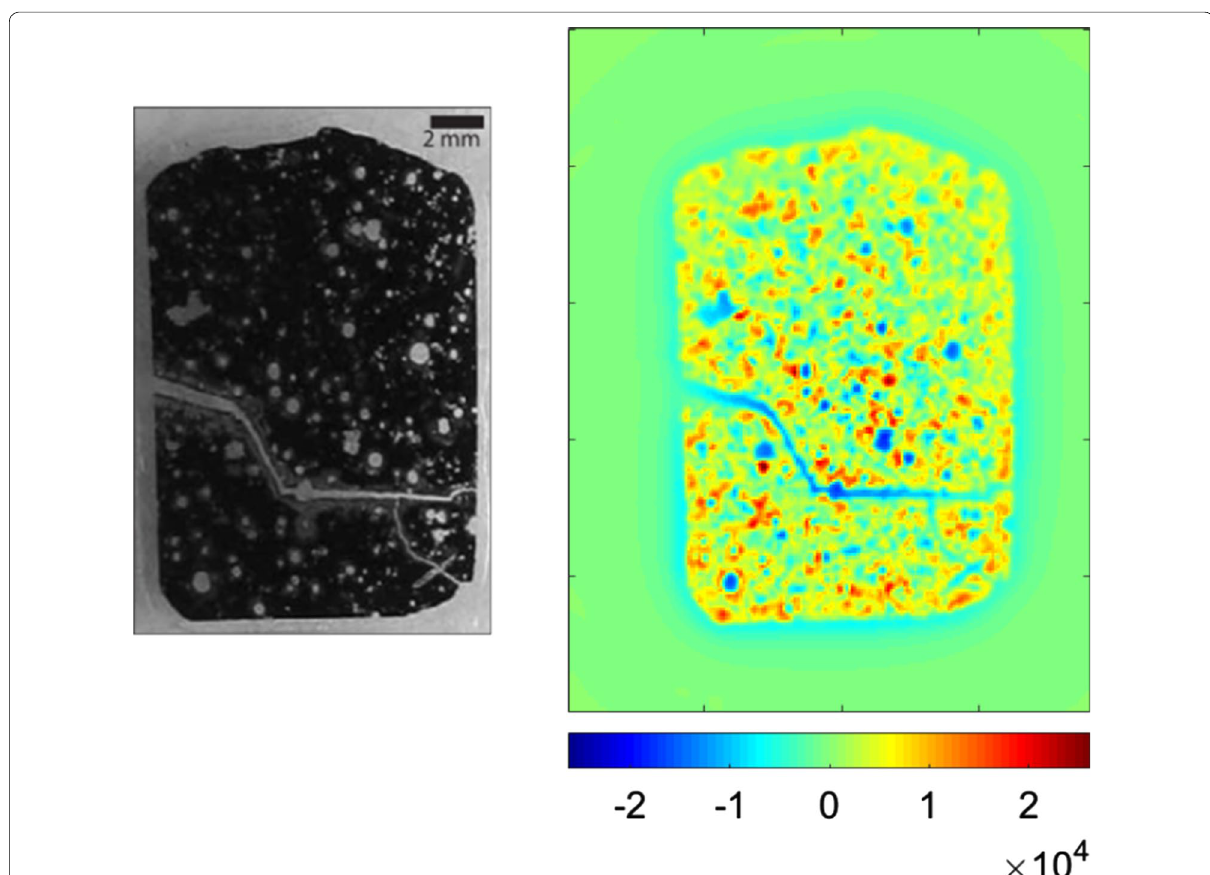
Fig. 6 At left is a reflected light photo of the Hawaiian basalt thin section. At right is the SIRM B z field map (the positive z -direction is out of page) obtained with a scanning SQUID in nT at a 100 µ m resolution with a sensor-to-sample distance of 200 µ m. The B z field of view is 19.0 mm × 25.0